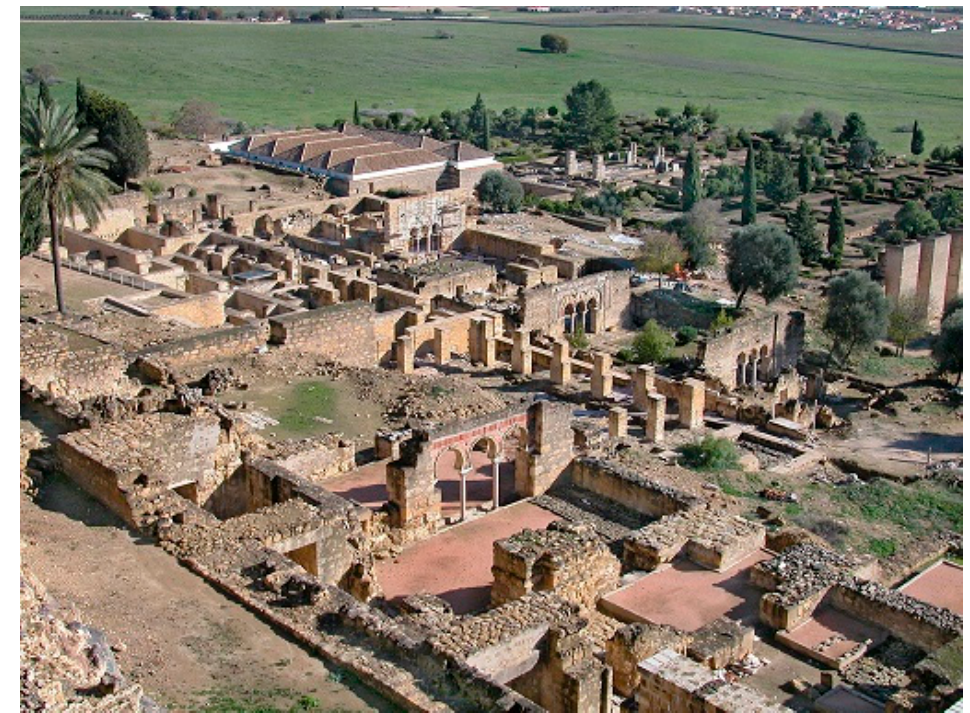
Figure 3. Qa ṣ r view with the D ā r al-Mulk as a visual reference in the foreground. (Photo M. Pijuán © Figure 3. Qas.r view with the D¯ar al-Mulk as a visual reference in the foreground. (Photo M. Piju á n © Conjunto Arqueológico de Madinat al-Zahra). Conjunto Arqueol ó gico de Madinat